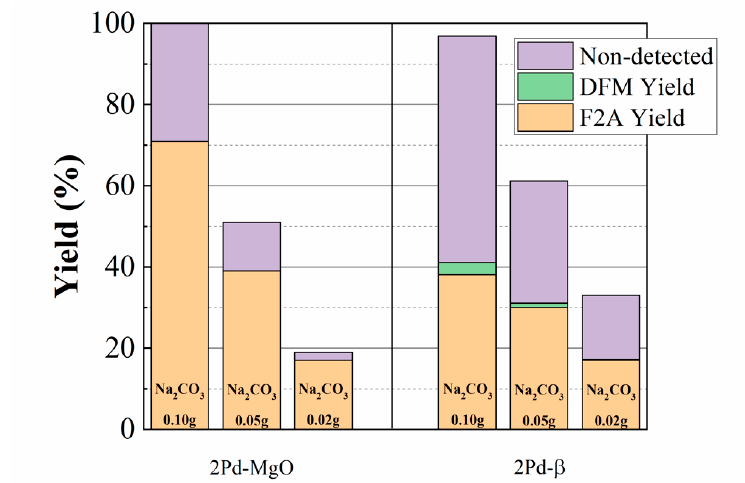
Figure 11. Influence of the Na 2 CO 3 addition on Pd-based catalysts supported on MgO and β -zeolite. Experimental conditions: temperature: 170 °C, time: 3 h, catalyst loading: 0.05 g, V (ethanol) : 6 mL, V (H 2 O 2 , 30 wt%): 0.5 mL.